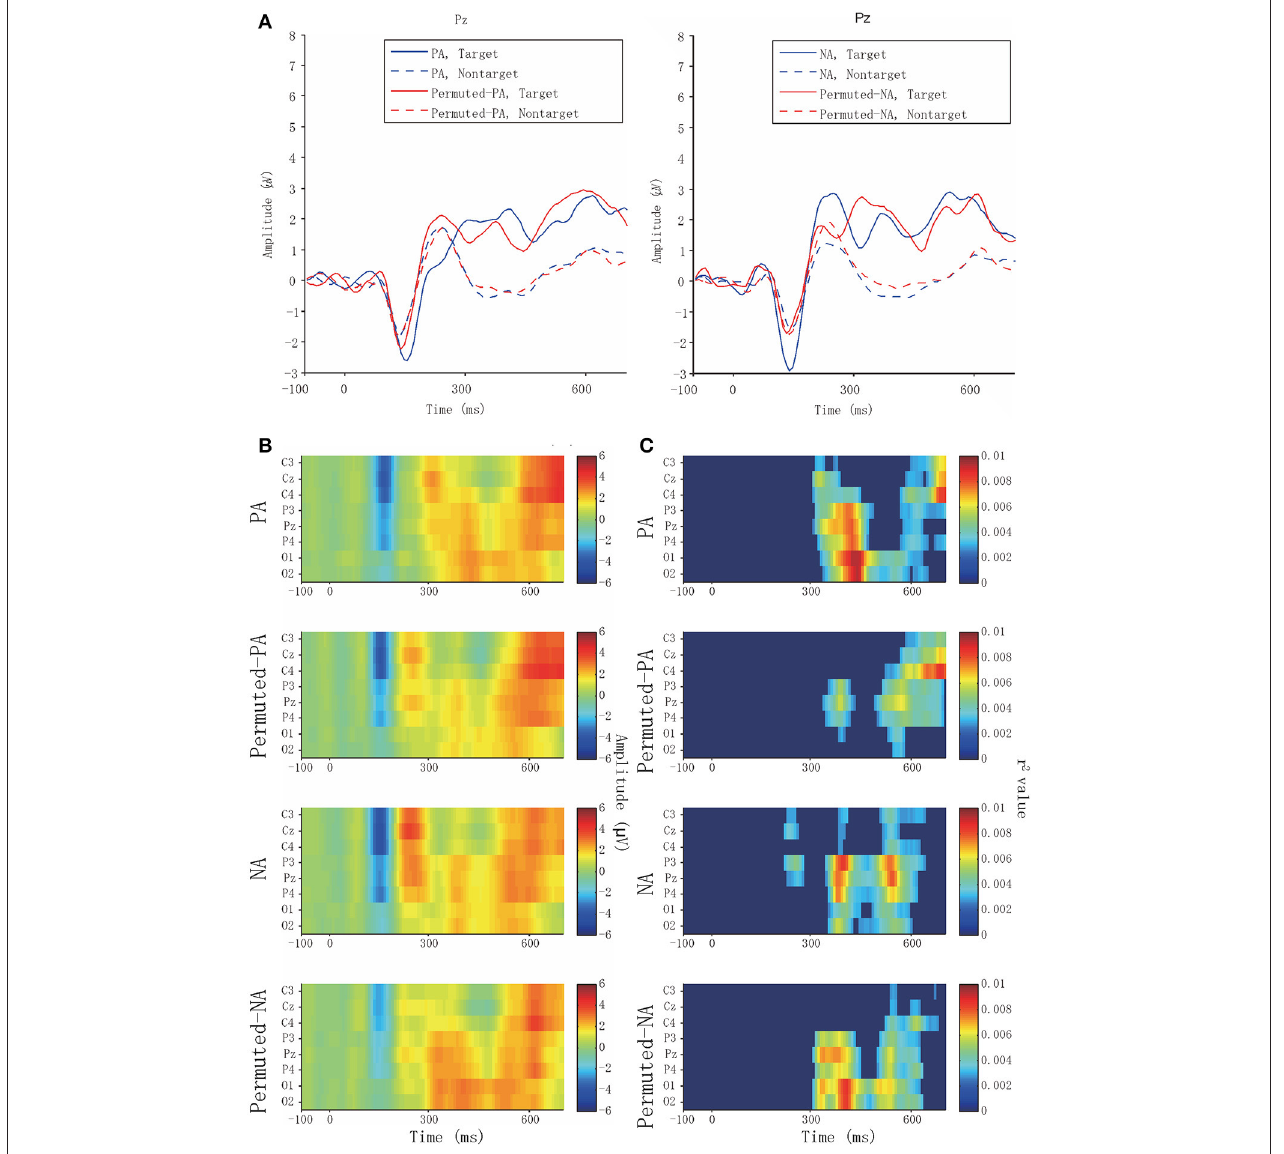
FIGURE 3 | Averaged waveforms and biserial correlation coefficients ( r 2 value). (A) Target and non-target averaged waveform of PA, permuted-PA, NA, and permuted-NA at Pz. Solid and broken lines represent the target and non-target ERPs, respectively. The blue lines represent PA or NA, and the red lines represent permuted-PA or permuted-NA. (B) Averaged waveforms in PA, permuted-PA, NA, and permuted-NA observed from eight channels. (C) Biserial correlation coefficients in PA, permuted-PA, NA, and permuted-NA. The biserial correlation coefficients were visualized as zero if the point-biserial correlation was determined to be insignificant through a test of no